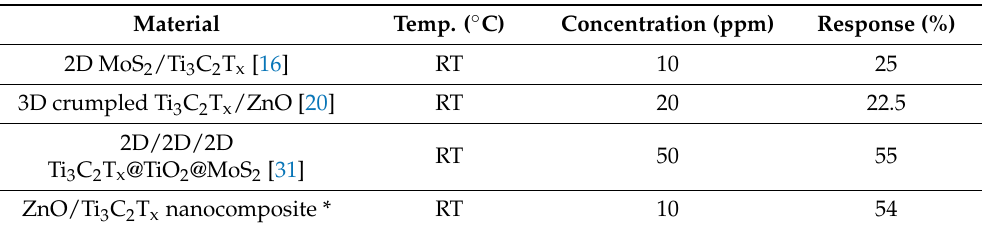
Figure 6. ( a ) NO 2 response curves of pure Ti 3 C 2 T x MXene and ZnO/Ti 3 C 2 T x nanocomposite (ZT2). ( b ) Comparison of NO 2 responses of ZT1, ZT2, and ZT3. ( c ) Cyclic responses of NO 2 gas at different times. ( d ) Comparison of responses of ZT2 sample to various gases at 10 ppm concentration. ( e ) Calibration curve of sensor response versus NO 2 concentration using logarithmic plot. ( f ) Cyclic responses of ZT2 to the different concentration of NO 2 . Table 1. The comparison of NO 2 sensing in other materials, including Ti 3 C 2 T x MXene, was explored in previous